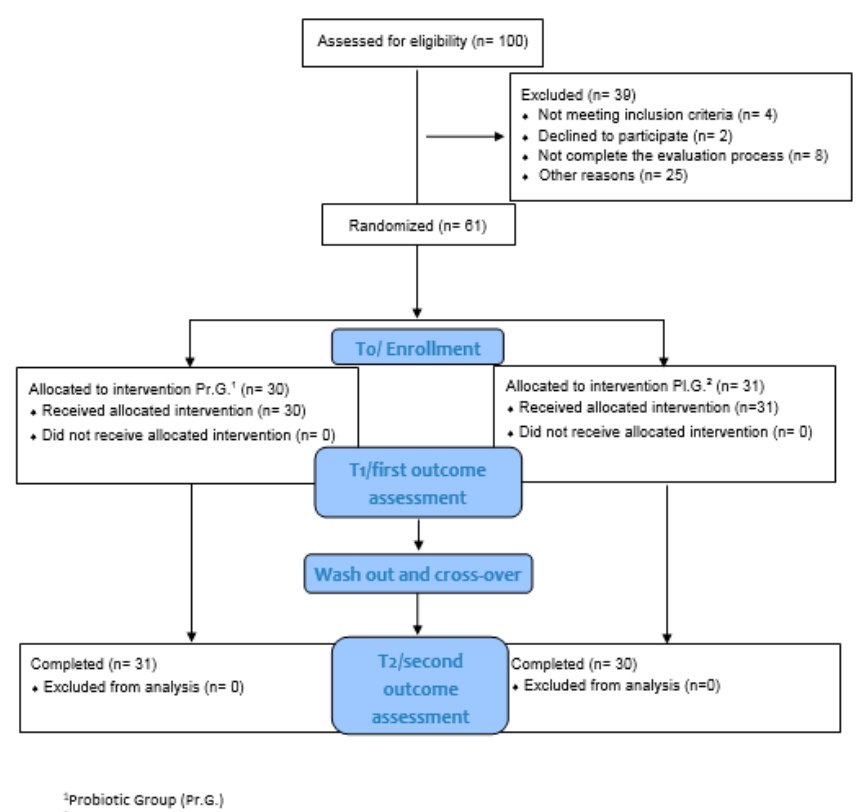
Figure 1. Flow chart enrollment of patients included in the study.